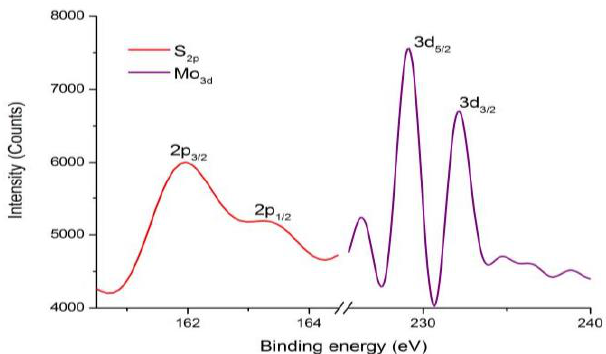
Figure 8. XPS spectra of Mo 3d and S 2p for the monolayer MoS 2.